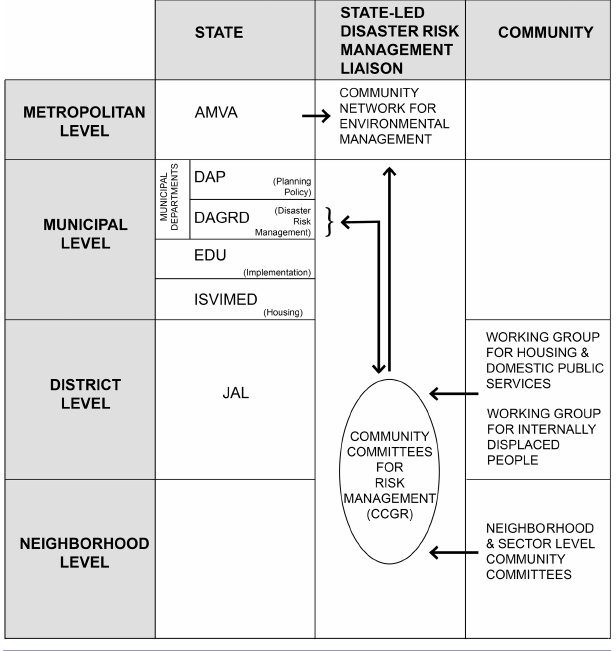
Fig. 2 . State-led community involvement in disaster risk